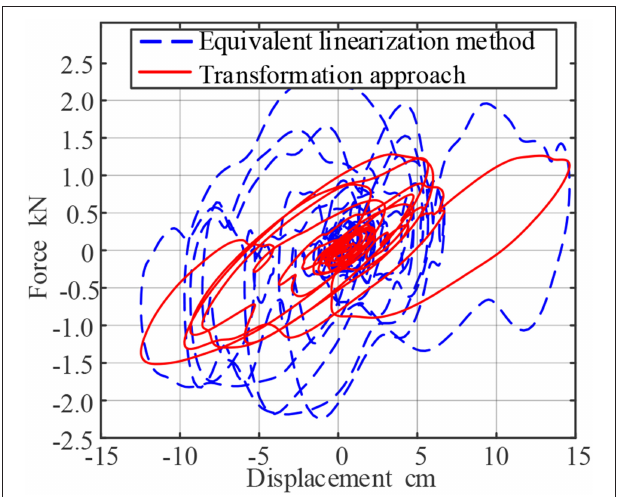
FIGURE 8 | Force-Displacement curve of viscoelastic resistance under seismic load (assuming working frequency is 0.2Hz).